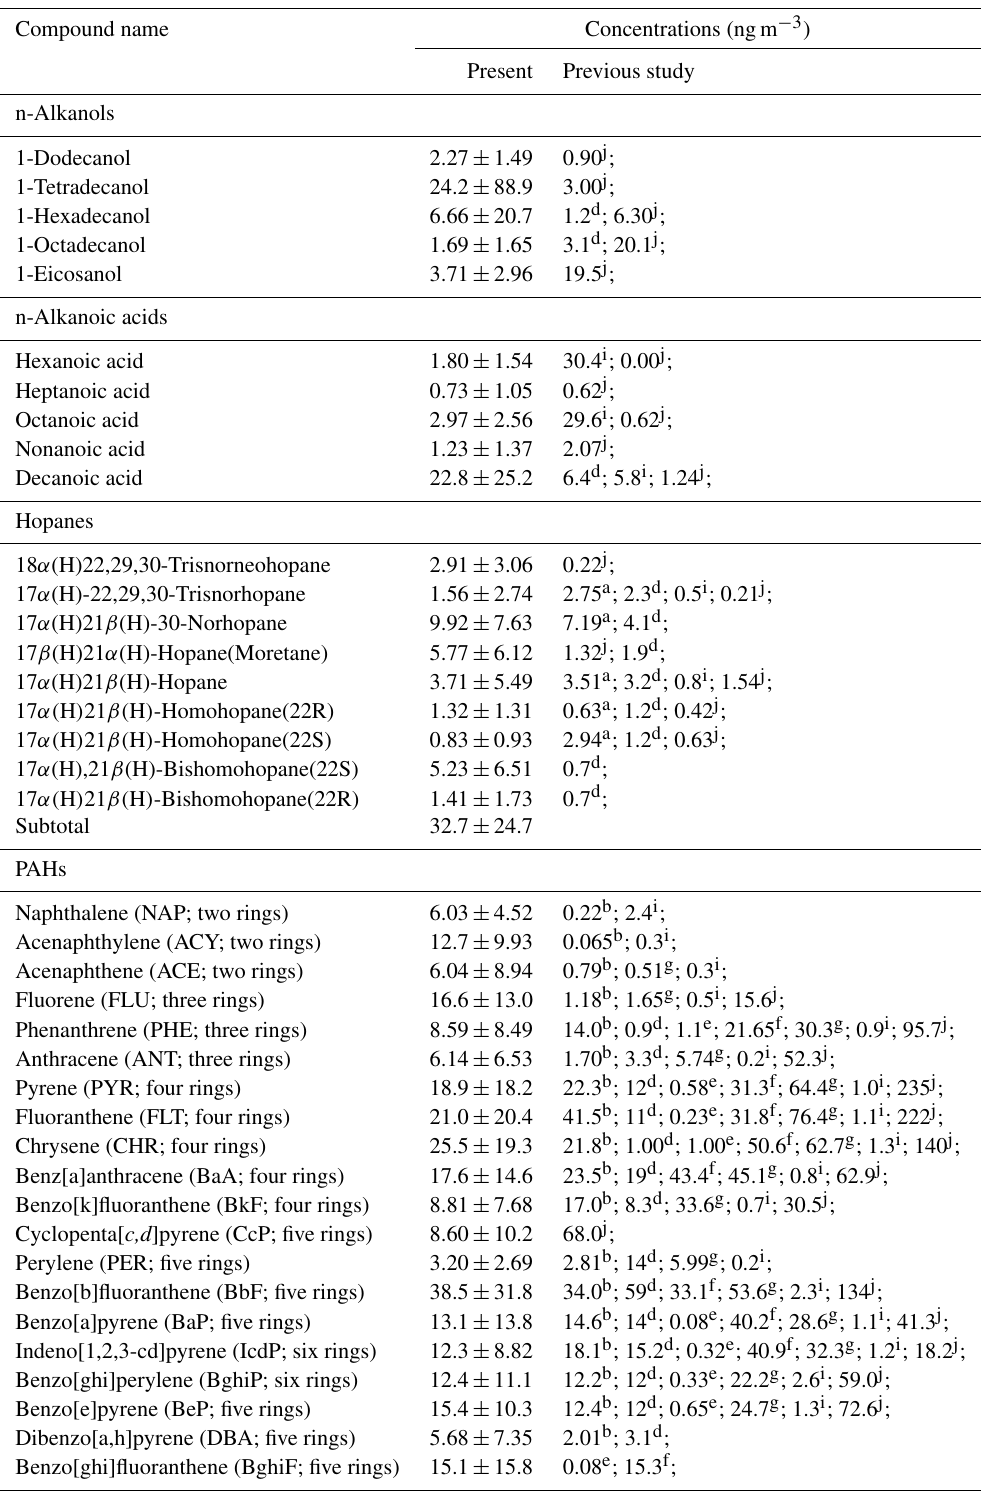
Table 1. Comparison of identified organic compounds with earlier studies in Beijing. Data from the present study are mean ± standard deviation for n = 33